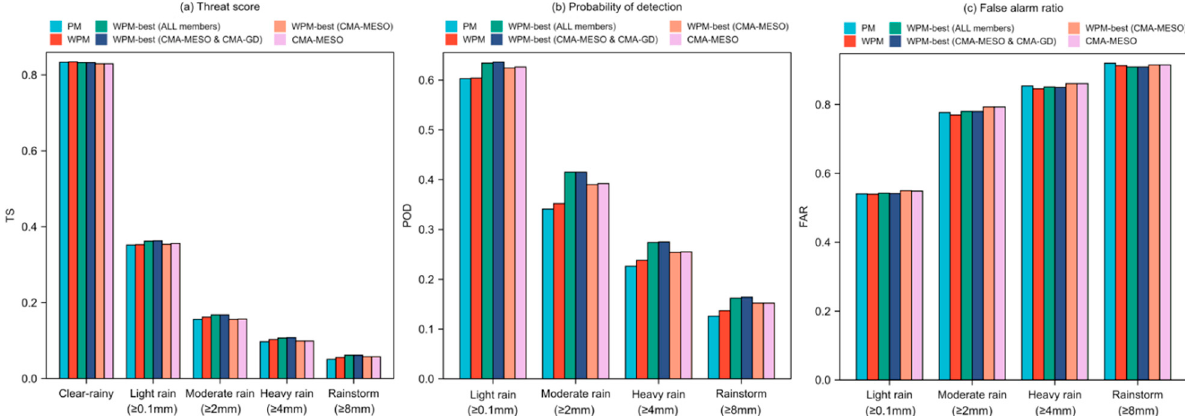
Figure 6. Performance of multi-model hourly QPF before and after different calibrated methods. The details of the calibration method are shown in Figure 3.